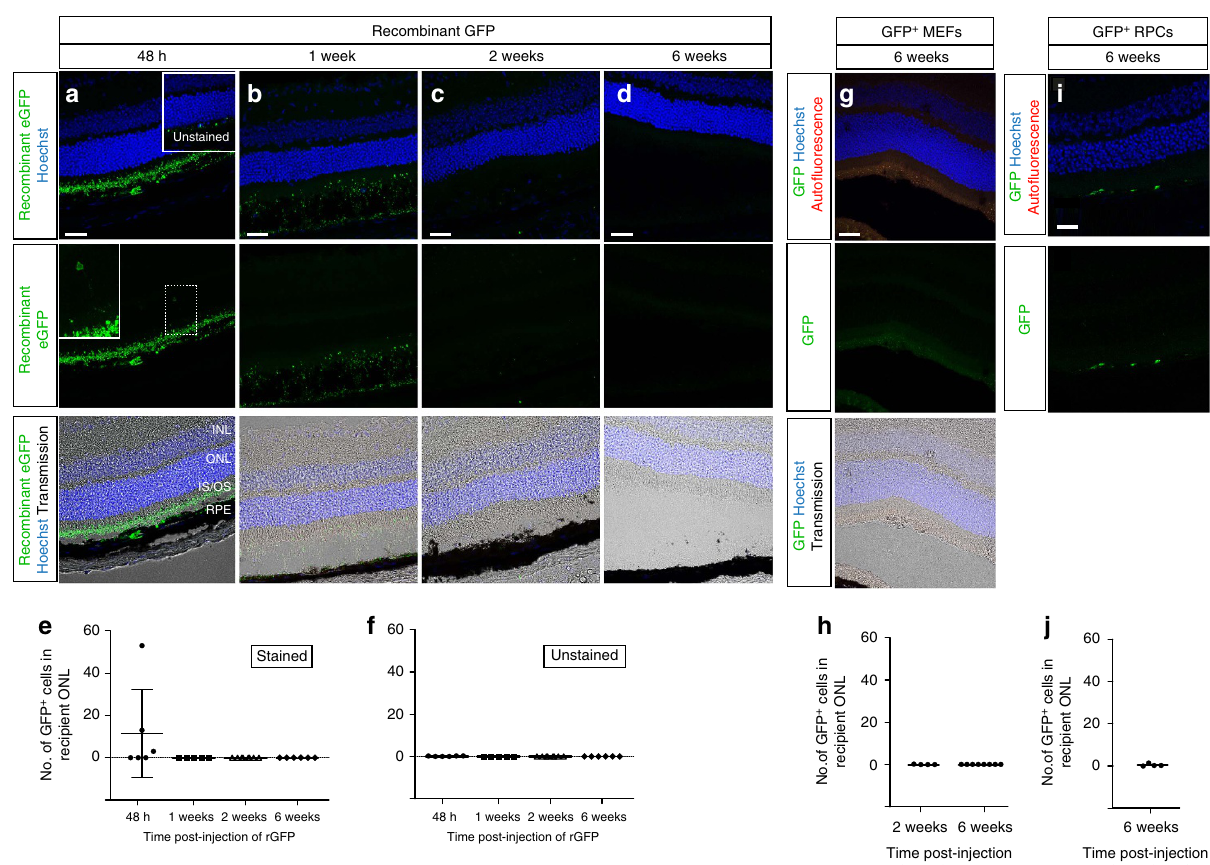
Figure 6 | Material transfer is specific to photoreceptor precursors and does not result from uptake of free proteins from environment. ( a – d ), confocal projection images of adult retinal sections taken at 48h, 1 week, 2weeks and 6 weeks post-injection of rEGFP and stained with anti-GFP antibody ( green ). Insert , Very few GFP þ cells were seen; those that were had normal rod photoreceptor morphology. ( e , f ) Scatter plots showing the mean ( ± s.d.) number of GFP þ cells within the host ONL at each time point in stained and unstained serial sections. ( g ), confocal projection images of retinal sections taken at 6 weeks post-injection of GFP þ fibroblasts. ( h ), scatter plot showing the number of GFP þ cells within the host ONL. ( i ), confocal projection images of retinal section taken at 6 weeks post-injection of E11.5 GFP þ retinal progenitor cells (RPCs). ( j ), scatter plot showing the number of GFP þ cells within the host ONL. For panels ( a )-( d ) and ( g ),( h ), images from top to bottom show individual and/or combined channels for the same region of interest. Scale bars 50 m